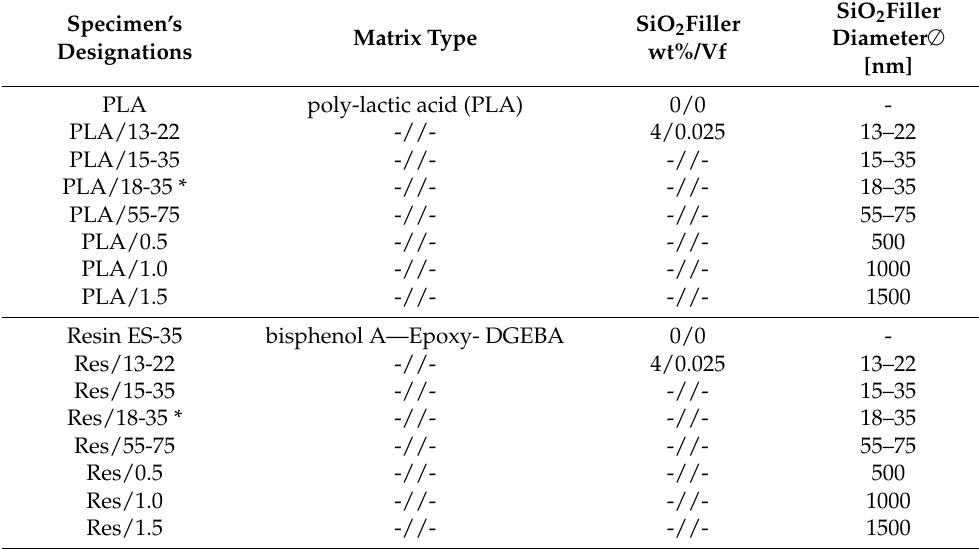
Table 1. Micro- and Nano-composites Manufactured and Related Specimen’s